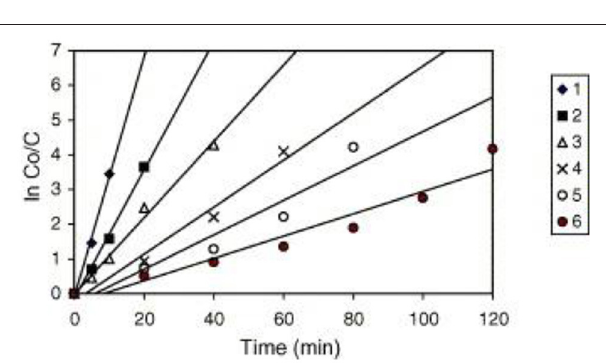
FIGURE 4 | Kinetics of RY14 decolorization by UV/TiO2-P25 for different initial dye concentrations. TiO2-P25 = 4 g/l, pH 5.5 ± 0.1. [1] = 1 × 10 − 4 mol/l, [2] = 2 × 10 − 4 mol/l, [3] = 3 × 10 − 4 mol/l, [4] = 5 × 10 − 4 mol/l, [5] = 7 × 10 − 4 mol/l, and [6] = 9 × 10 − 4 mol/l ((Muruganandham and Swaminathan, 2006); Reprinted by